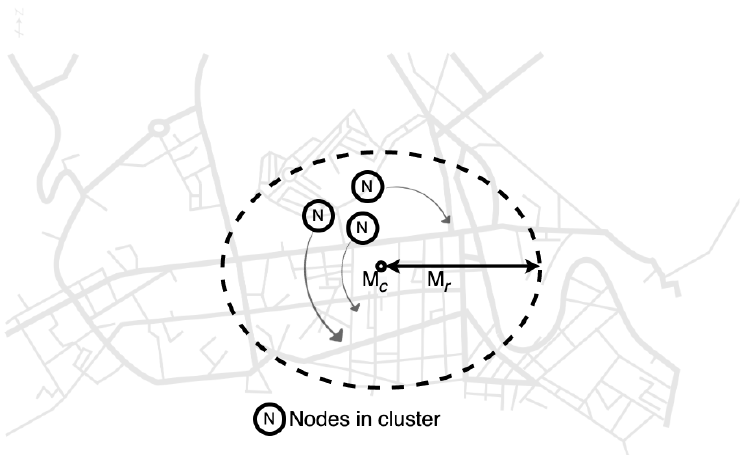
Figure 5. Cluster movement model integrated in the ONE